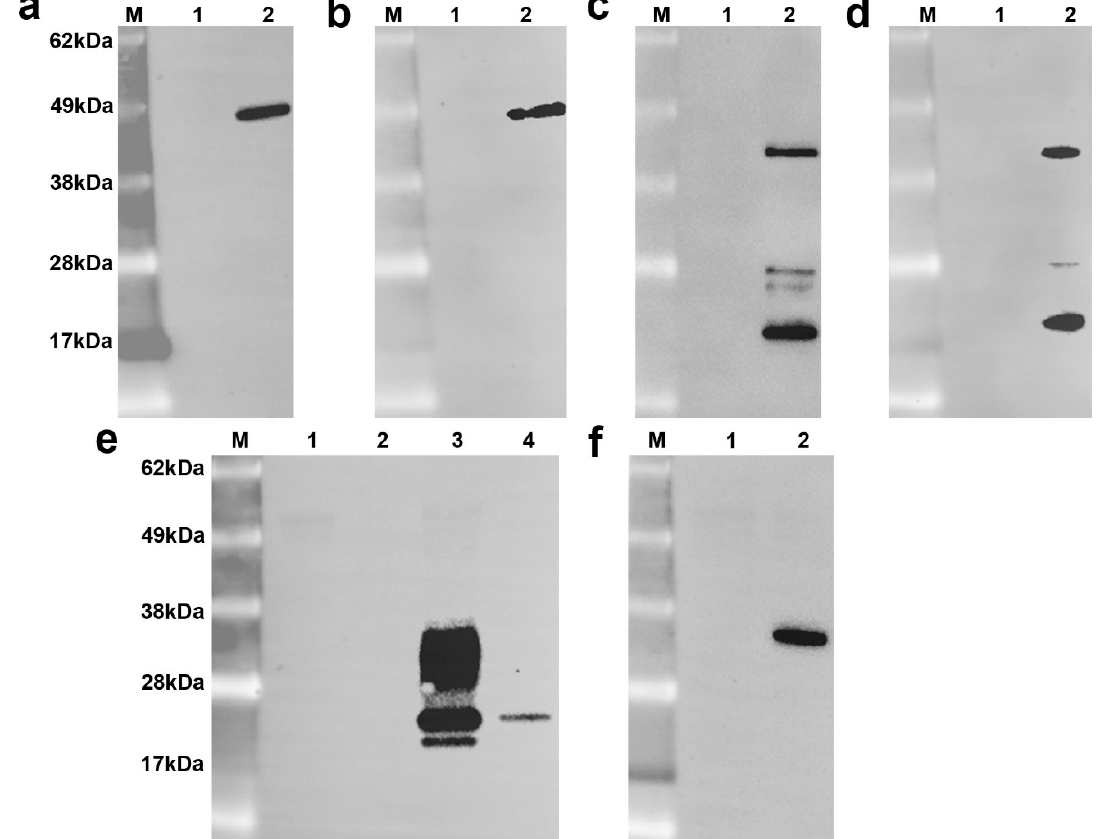
Figure 3. Immunoblot of BTV-1-infected cells using BTV antibodies specific for NS1, NS2, NS3 / 3a, and VP7. The blots shown were stained with NS1 monoclonal antibody (mAb) 31D11 ( a ), NS1 mAb 20A8 ( b ), NS2 mAb 30G4 ( c ), NS2 mAb 465 ( d ), NS3 mAb 441 ( e ), and VP7 polyclonal antibody 20-3 ( f ). The lanes for the images of NS1, NS2, and VP7 are as follows: molecular weight marker (M), mock-infected cell lysate diluted 1:8 (lane 1), and BTV-infected lysate diluted 1:8 (lane 2); and for NS3 / 3a blot, as follows: molecular weight markers (M), mock-infected cell lysate undiluted (lane 1) and diluted 1:8 (lane 2), and BTV-infected cell lysate undiluted (lane 3) and diluted 1:8 (lane 4).